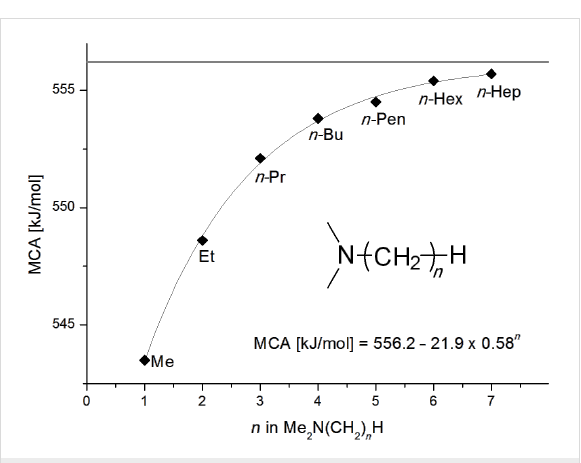
Figure 1: MCA values of monosubstituted amines of general formula Me 2 N(CH 2 ) n H ( n = 1–7, in kJ/mol).